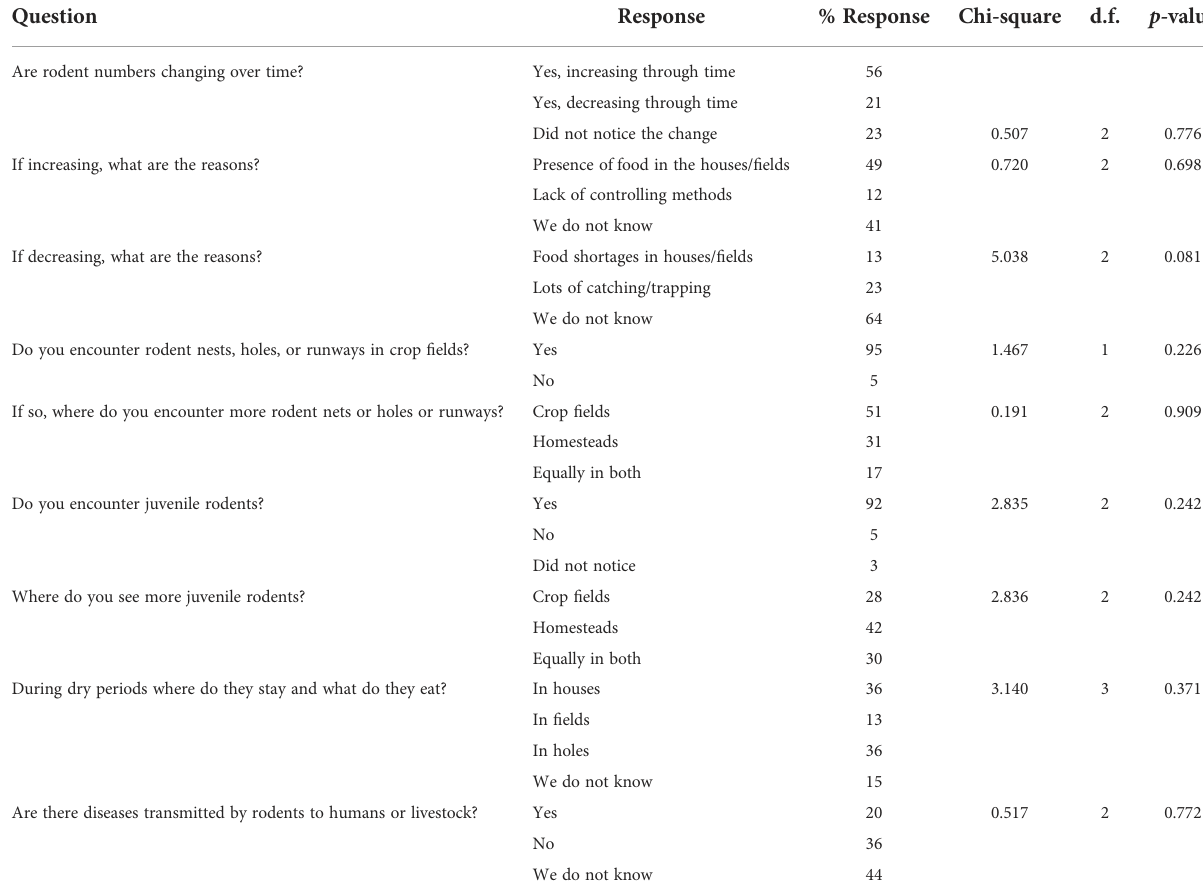
TABLE 3 Farmers ’ perceptions on temporal and spatial rodent population